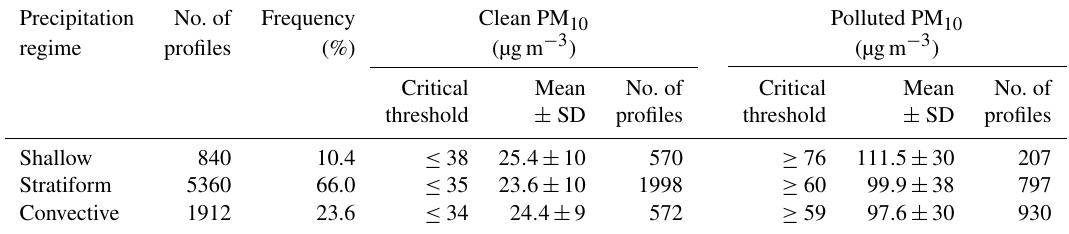
Table 2. Statistics describing the three precipitation regimes analyzed in the study. The critical PM 10 thresholds discriminating between clean (bottom 1 / 3) and polluted (top 1 / 3) conditions and their corresponding mean PM 10 concentrations are also listed, so are the number of precipitation profiles. Data are from TRMM PR retrievals made over the PRD region. Precipitation No. of Frequency Clean PM 10 Polluted PM 10 regime profiles (%) (µgm − 3